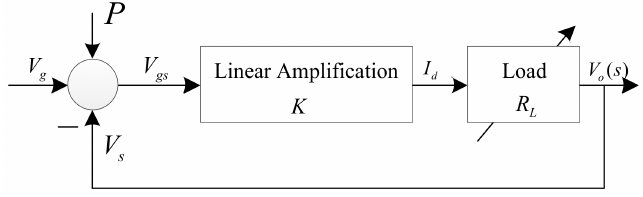
Figure 6. The control block diagram of the MOSFET.